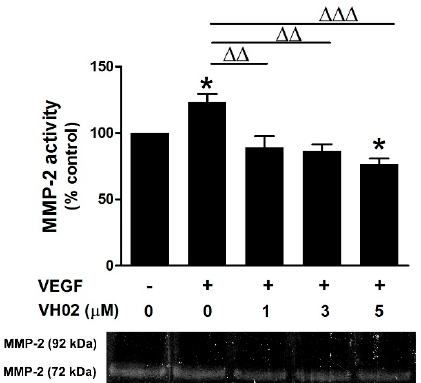
Figure 3. MMP-2 inhibitory effect of VH02 on EA.hy 926 cells. Representative gelatin zymography shows a clear visible band of MMP-2 activity at 72 kDa while MMP-9 activity at 92 kDa was not observed. The activity of MMP-2 was quantified by the band density and analyzed by Image J software. The data are expressed as percentage of reference control. * p < 0.05 versus vehicle control; ΔΔ p < 0.01; ΔΔΔ p < 0.01 versus VEGF (25 ng/mL) alone.